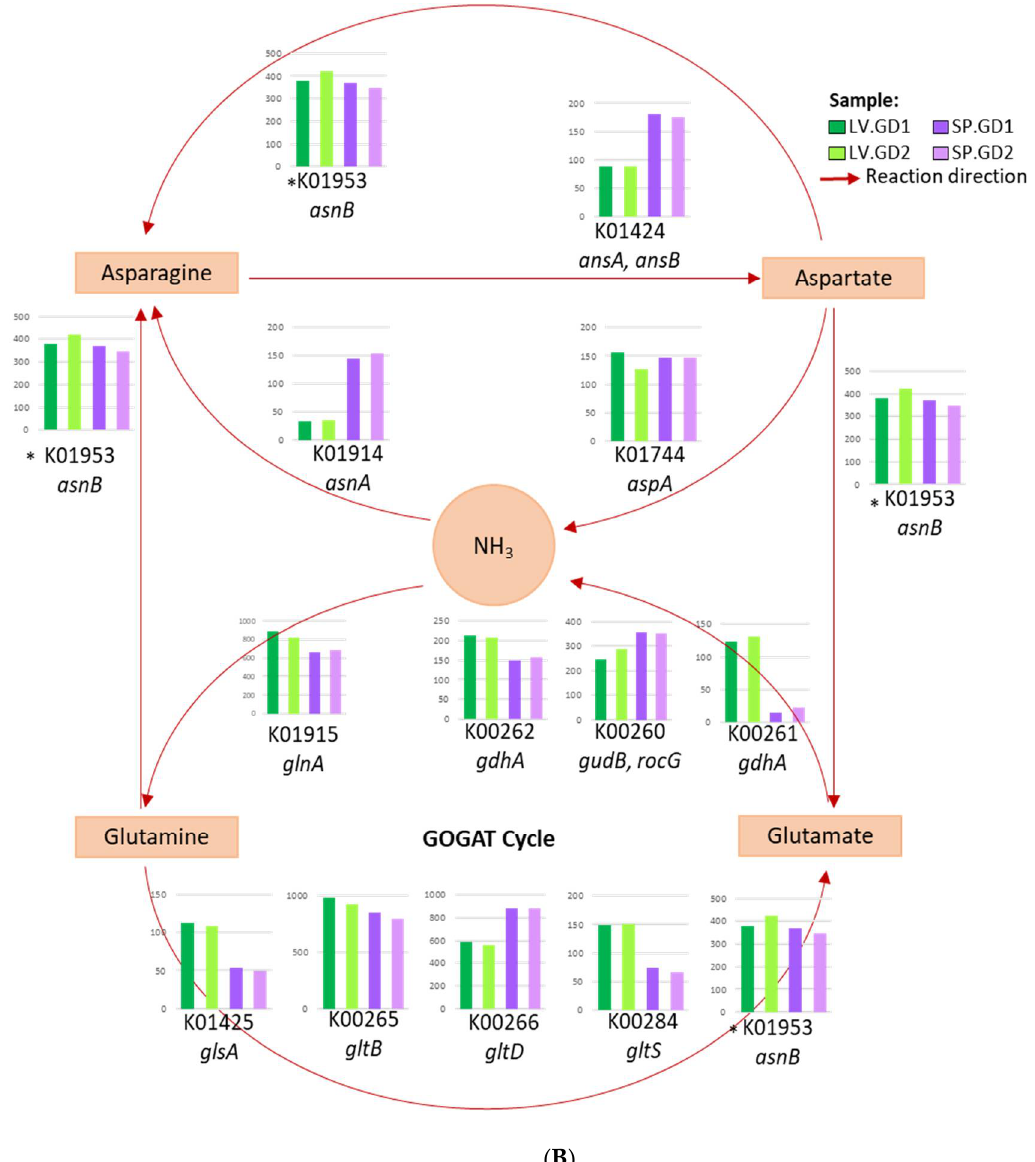
Figure 5. ( A ) The KEGG Orthology (KO) functional categories comprising the KEGG-Level-3 pathway of nitrogen metabolism (00910), including the direction of the reaction, were mapped. Inorganic nitrogen metabolism was mapped to show the substrate and product of each indicated reaction as it pertains to nitrate (NO 3 − ) reduction, nitrite (NO 2 − ) ammonification, denitrification to nitric oxide (NO), nitrous oxide (N 2 O), and nitrogen gas (N 2 ), and nitrogen fixation into ammonia (NH 3 ). ( B ) The KEGG Orthology (KO) functional categories comprising the KEGG-Level-3 pathway of nitrogen metabolism (00910), including the direction of the reaction, were mapped. The assimilation of ammonia into the amino acids glutamine and asparagine are also shown, including the subsequent enzyme-catalyzed amino acid transitions. The count data associated with the specified gene are shown as column bar graphs for each sample, including the KO category (KO number) and the gene name assigned through the KEGG database. Each category was color-coded according to their sample indicated in the color key as follows: SP.GD = purple sea urchin Strongylocentrotus purpuratus gut digesta; SP.GD1 = purple and SP.GD2 = light purple; LV.GD = green sea urchin Lytechinus variegatus gut digesta; LV.GD1 = green and LV.GD2 = light green. The metabolic pathways were elaborated using the information provided through KEGG Mapper as implemented in MG-RAST (v4.0.3). * The KEGG number K01953 corresponding to the asnB gene is listed multiple times due to its function in the generation of glutamate and asparagine from glutamine and aspartate.